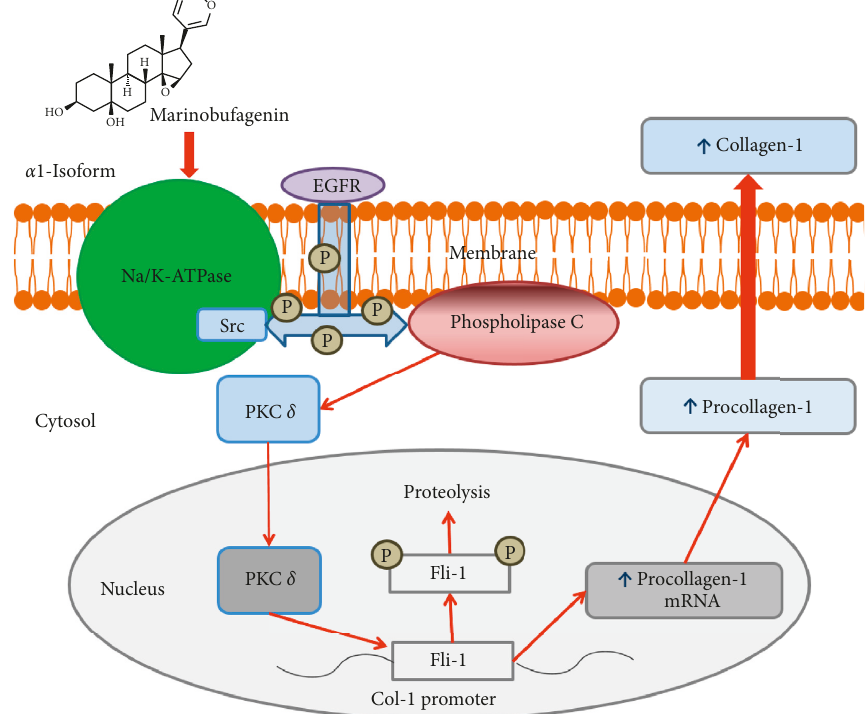
Figure 2: Scheme of the Fli-1-dependent profibrotic pathway activated via binding of marinobufagenin (MBG) to Na/K-ATPase (NKA). The interaction of MBG with NKA leads to activation/phosphorylation of Src followed by activation/phosphorylation PLC and PKC via scaffolding function of NKA.